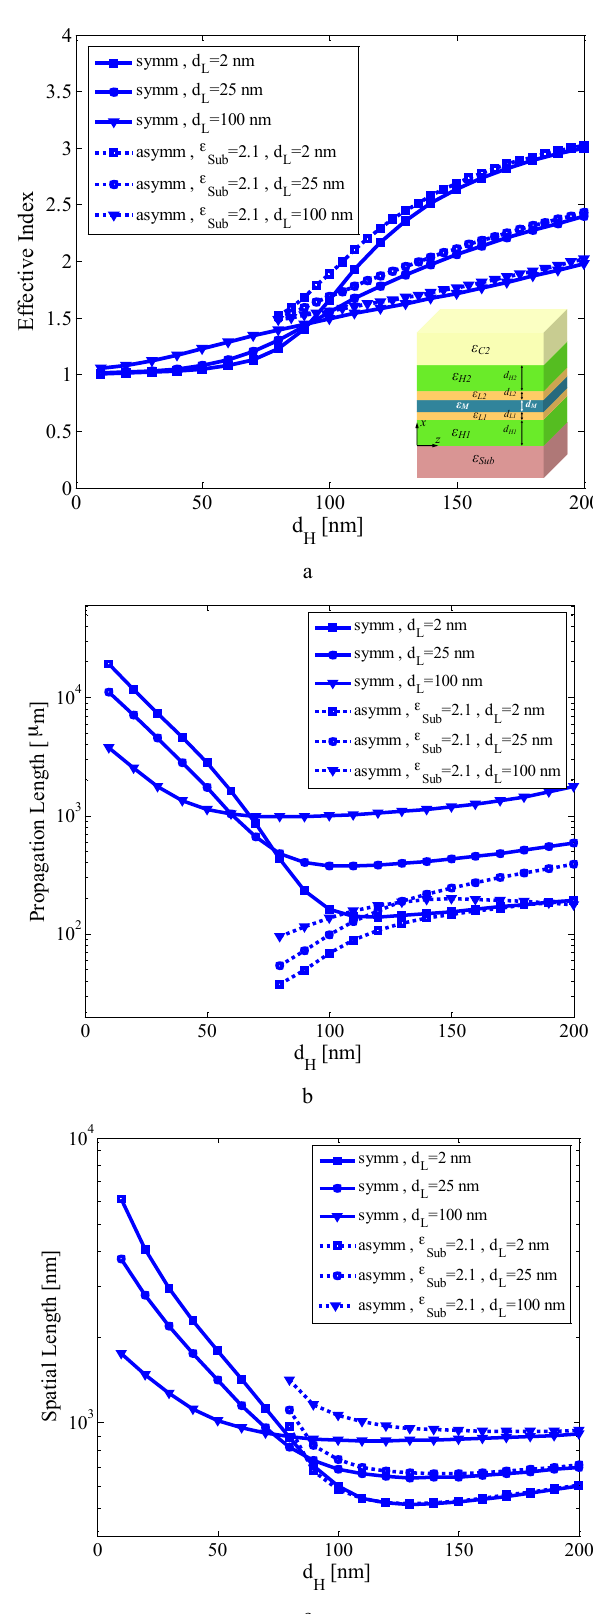
Figure 12: Comparing the propagation properties of HIMI slab waveguide with and without silica substrate: a. effective refractive index, b. propagation length and c. spatial